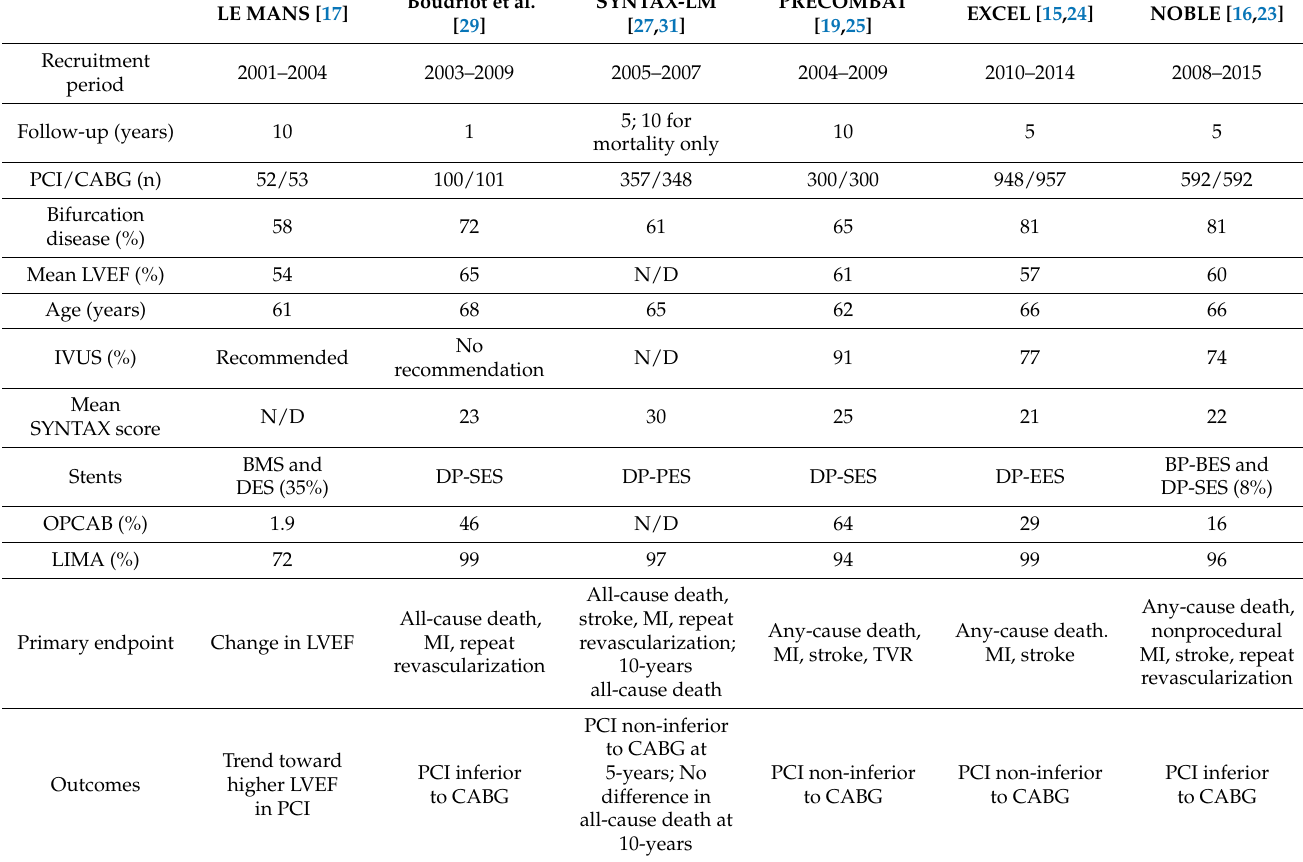
Table 1. Summary of random clinical trials comparing PCI with CABG in left main coronary artery